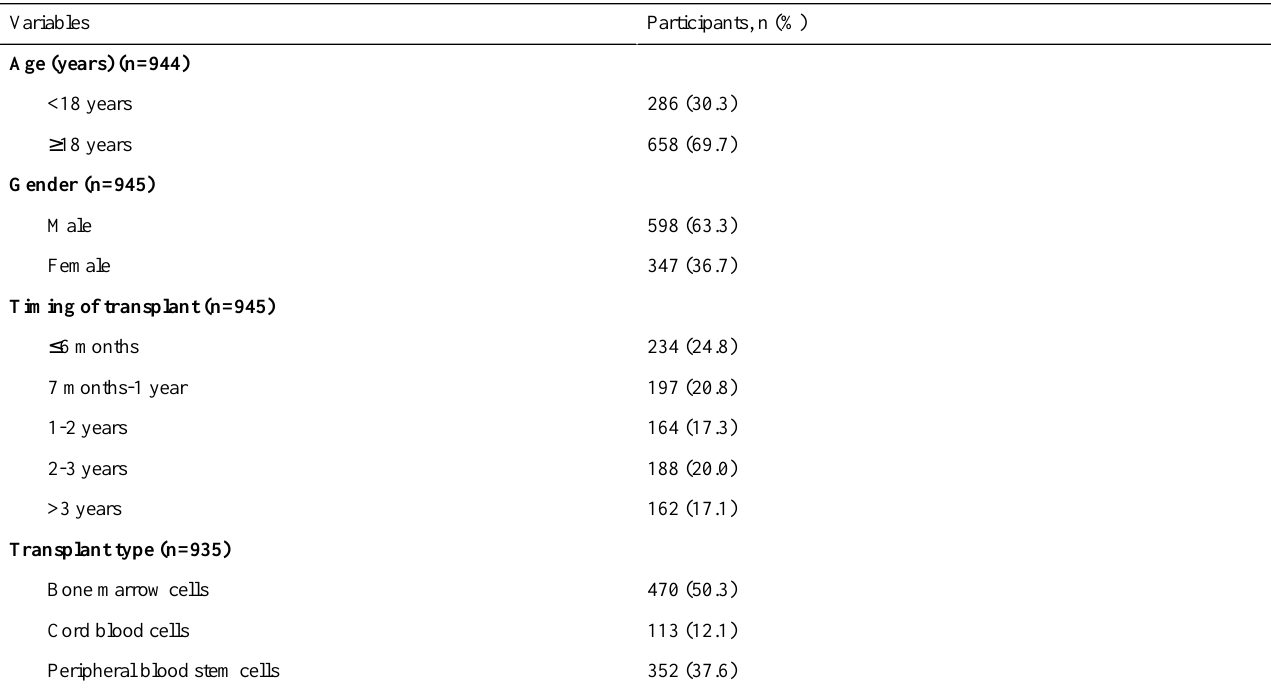
Table 2. Summary of care recipient